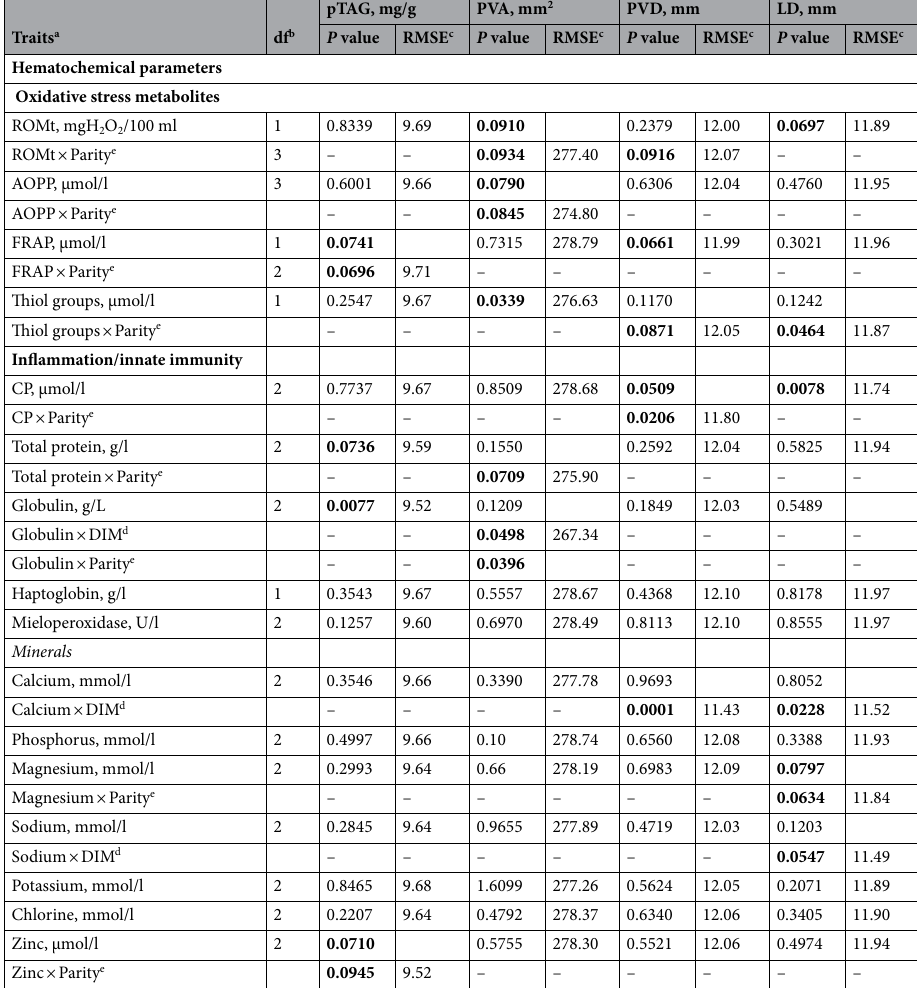
Table 3. Results from linear mixed model ( P values) for predicted liver triacylglycerol (pTAG), portal vein area (PVA), portal vein depth (PVD) and liver depth (LD). P values < 0.1 are highlighted using bold. a ROMt, total reactive oxygen metabolites; AOPP, advanced oxidation product of protein; FRAP, ferric reducing antioxidant power; CP, ceruloplasmin. Linear models for pTAG, PVA, PVD and LD always considered the individual sources of variations, namely days in milk (DIM), parity and herd/date and, one at the time, all the hematic variables (in classes). Where P values were < 0.1, interactions between DIM and/or parity and hematic variables are reported. b df = the degrees of freedom depend on the number of classes in which hematochemical parameters have been discretized. c RMSE root mean square error. d DIM is constituted by 5 classes: